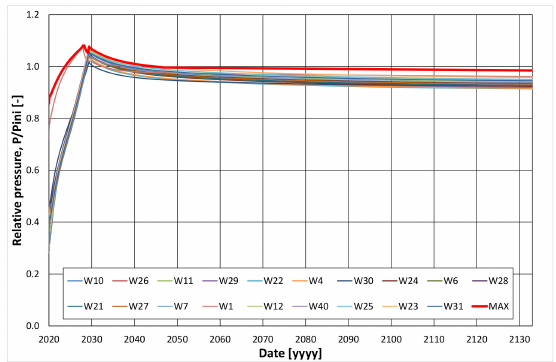
Figure 41. Maximum pressures along well trajectories. Maximum pressures among all well trajectories.